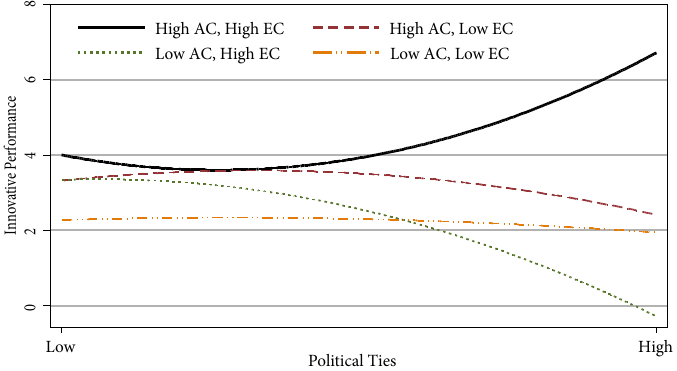
Figure 5. Curvilinear interaction of politic ties, absorptive capacity, and environmental complexity on corporate innovation